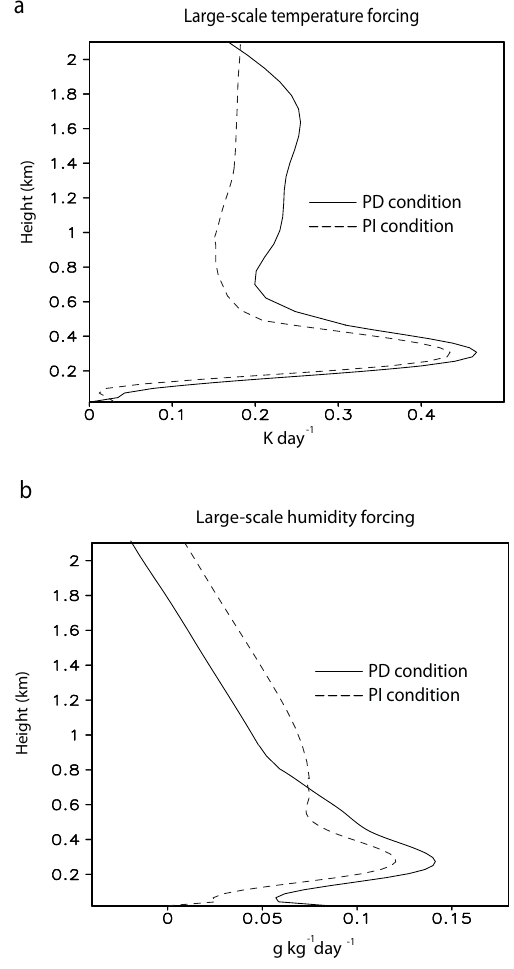
Fig. 1. Vertical profiles of (a) initial potential temperature and water vapor mixing ratio and (b) initial horizontal wind ( u , v ) velocity for the CSRM runs.